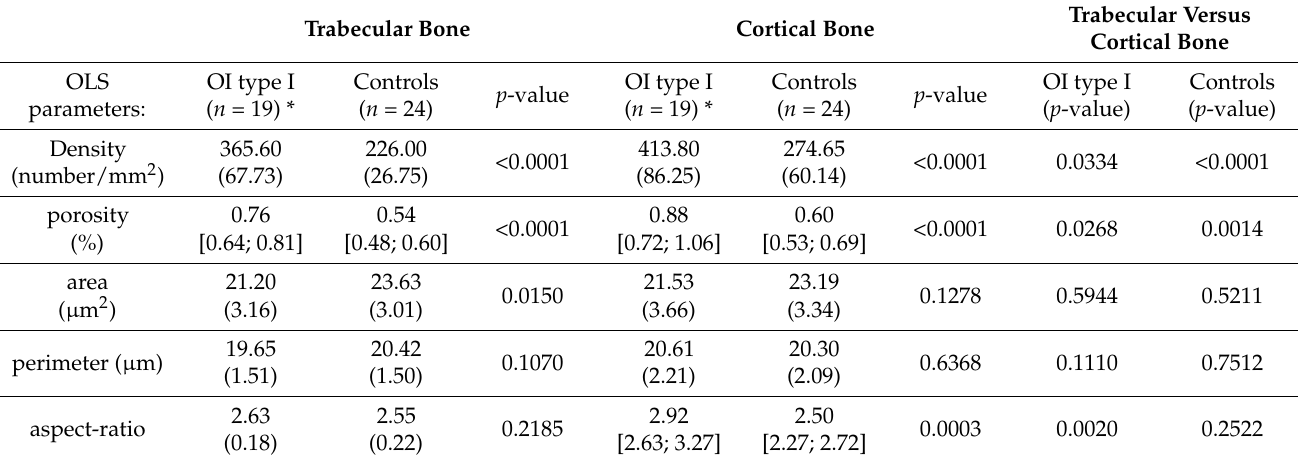
Table 1. Results of OLS analysis in trabecular and cortical bone from OI type I patients compared to